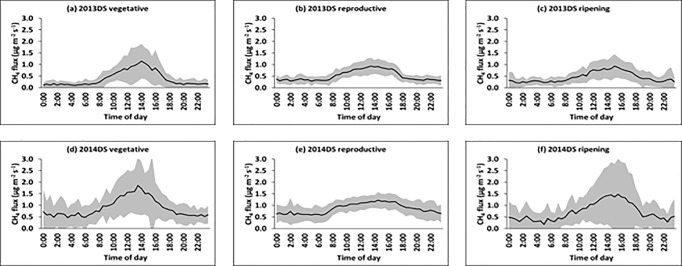
a,b,c,d,e,f. Mean diel patterns of CH4 flux during the different growth periods of the rice plant (vegetative, reproductive, and ripening) in the dry seasons (DS) of 2013 (a,b,c) and 2014 (d,e,f). The solid line represents the mean of all days at a given time of day (in 30 min intervals) and the shaded area represents the standard deviation.